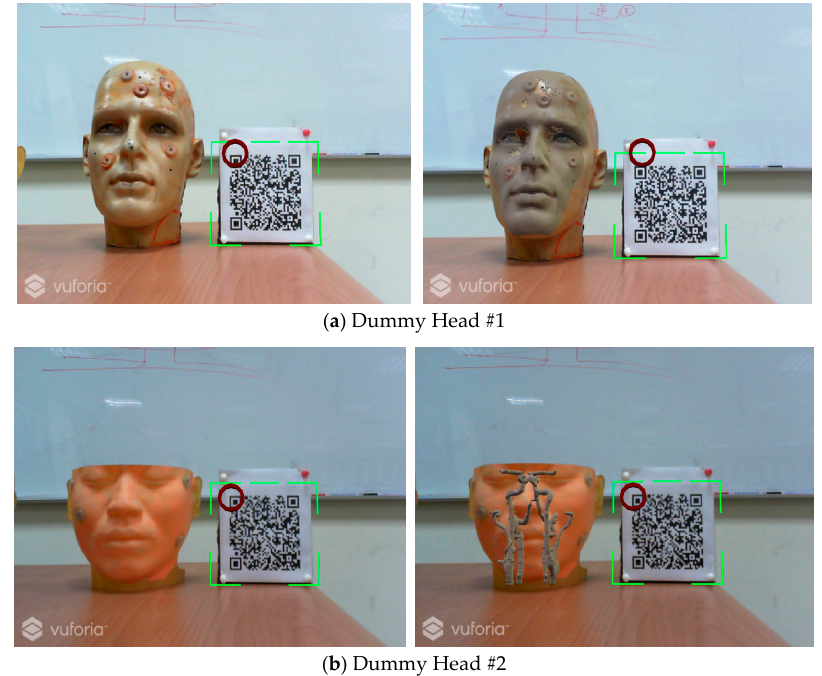
Figure 9. The Result of Marker Detection and Overlaying the Medical Images over the Dummy